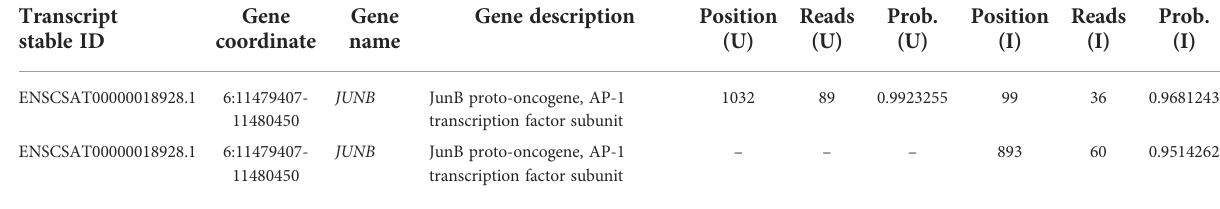
(Supplementary Figure S2). Functional enrichment analysis of Vero cell transcriptome from Taiaroa et al., 2020 points to the main BPs, such as “ cellular macromolecule metabolic process ” (GO:0044260), “ peptide metabolic process ” (GO:0006518), and “ protein metabolic process ” (GO:0019538) (Supplementary Figure S3). KEGG also pointed as main pathways involved: “ Ribosome ” (KEGG:03010), “ Protein processing in endoplasmic reticulum ” (KEGG:04141), and “ Cell cycle ” (KEGG:04110) (Supplementary Figure